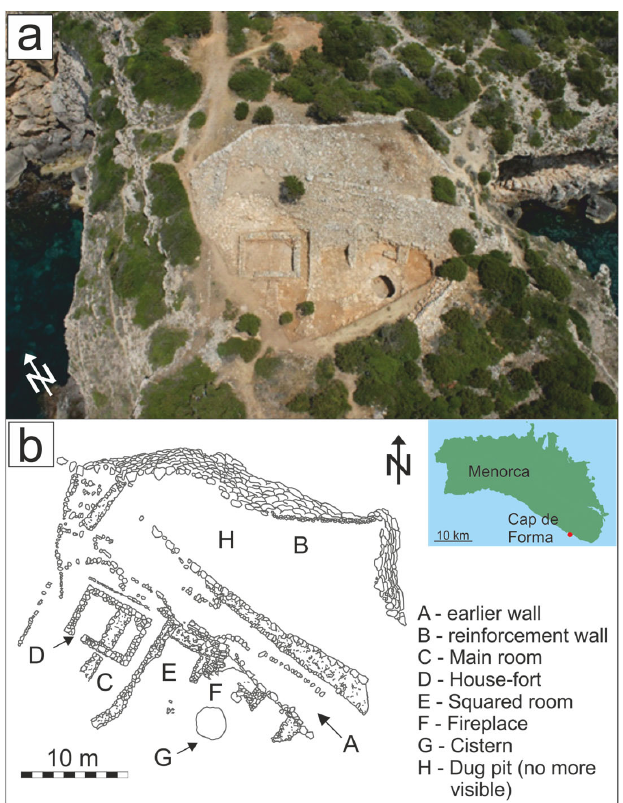
Figure 1. ( a ) Aerial view of the archaeological site of Cap de Forma (reprinted with permission from [46]. Creative commons (by ‐ nc ‐ nd), 2015). ( b ) Sketch map of the archaeological site indicating the most significant structures (modified after [42]).